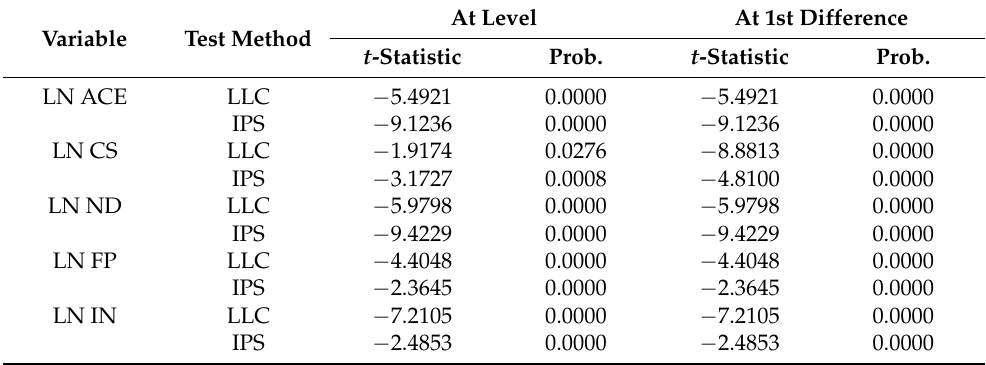
Table 3. Panel unit root test results.